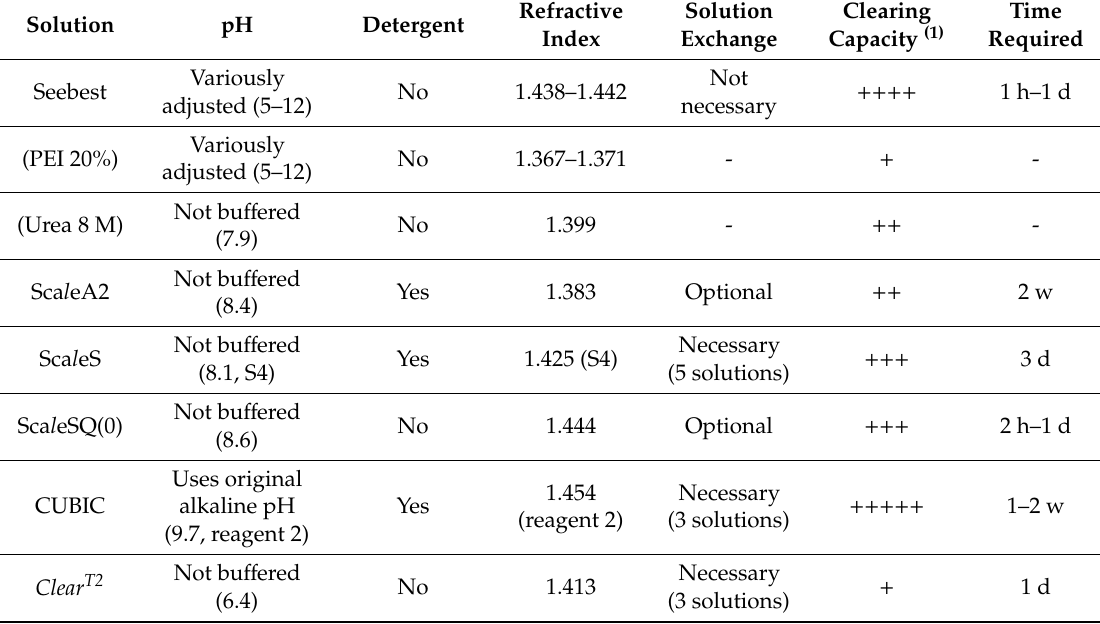
Table 1. Properties of aqueous solution-based tissue clearing